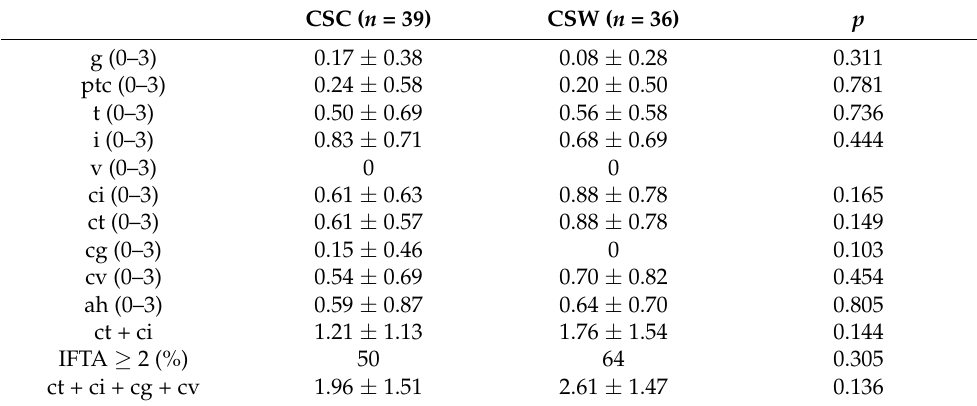
Abbreviations: ah, arteriolar hyaline thickening; ci, chronic interstitial fibrosis; cg, transplant glomerulopathy; ct, chronic tubular; cv, fibrous intimal thickening; g, glomerulitis; i, interstitial infiltration; ptc, peritubular capilaritis; t, tubulitis; v, arteritis; CSC, corticosteroid continuation; CSW, corticosteroid withdrawal. IFTA: proportion of patients with sum of interstitial fibrosis and tubular atrophy ≥